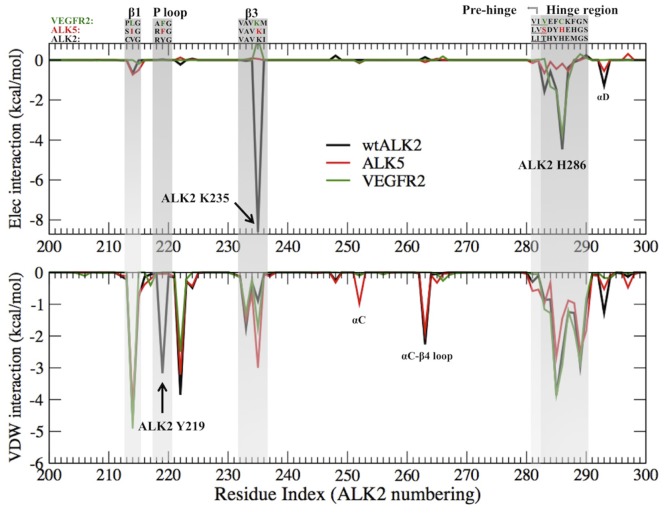
Per-residue interaction with DMH1 in wtALK2 (black), ALK5 (red) and VEGFR2 (green), averaged from the last 2 ns of trajectory.Top: electrostatic interaction. Bottom: van der Waals interaction. The three protein sequences are aligned by homology and the numbering is that of ALK2. The rest of the residues that have no interaction with DMH1 are not shown.